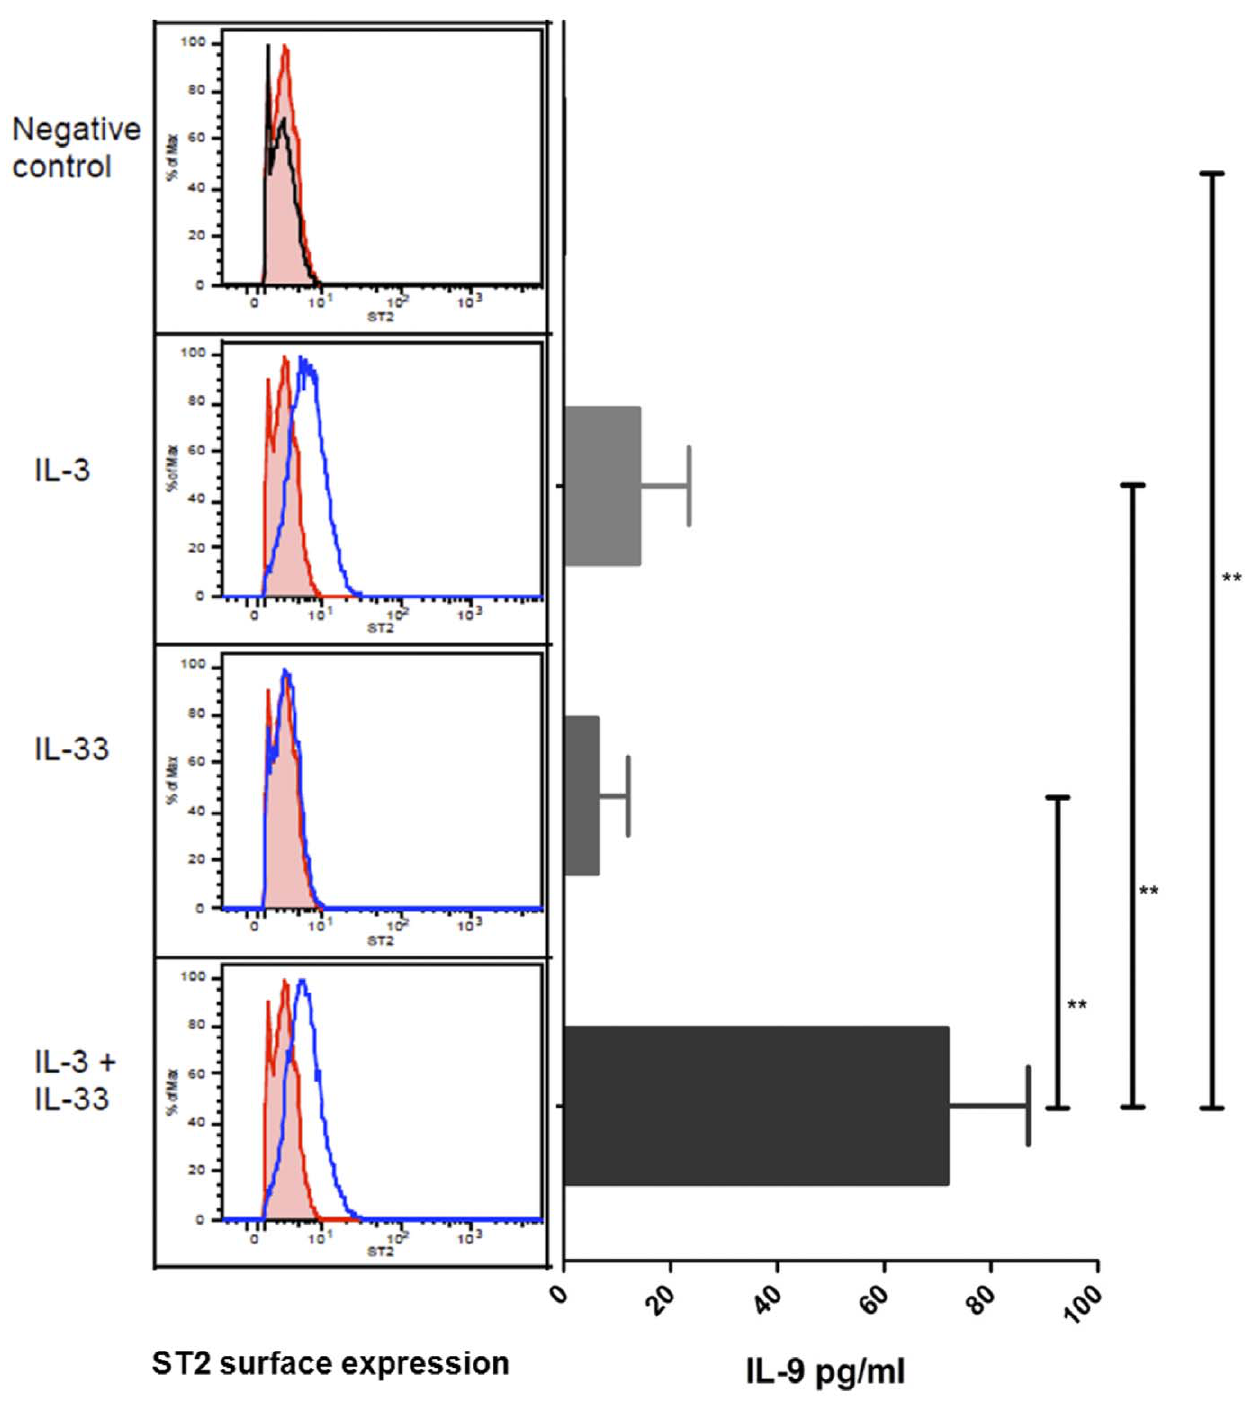
Figure 6. ST2 expression and IL-9 secretion from basophils stimulated with IL-3 and IL-33. Analysis of ST2 expression with FACS. Black line shows surface expression of ST2 on freshly isolated basophils at 0 h; tinted red shows negative control culture without cytokines after 24 h; blue lines show samples. Example from one donor included in both FACS and multiplex analysis is presented. In total, two independent experiments were performed, using two donors for each experiment, with similar results. Multiplex analysis of IL-9 in supernatant from a control culture or cultures with IL-3 and/or IL-33. Data are from two independent experiments, each with two donors. Vertical lines represent means (SEM). ** p , 0.01. doi:10.1371/journal.pone.0021695.g006 positive for PU.1 (Fig. 3B). As the calibrator had a CT value of protein levels of PU.1 were found positive, suggesting that PU.1 is not the master transcription factor in our culture system. However, approximately 30 it seems that the used probes anneal to human PU.1 and thus are functional (data not shown). When compared to gene and protein analysis at earlier time points is necessary to the isotype control, none of the cultures analyzed by FACS for exclude the importance of PU.1. Veldhoen et al. report an